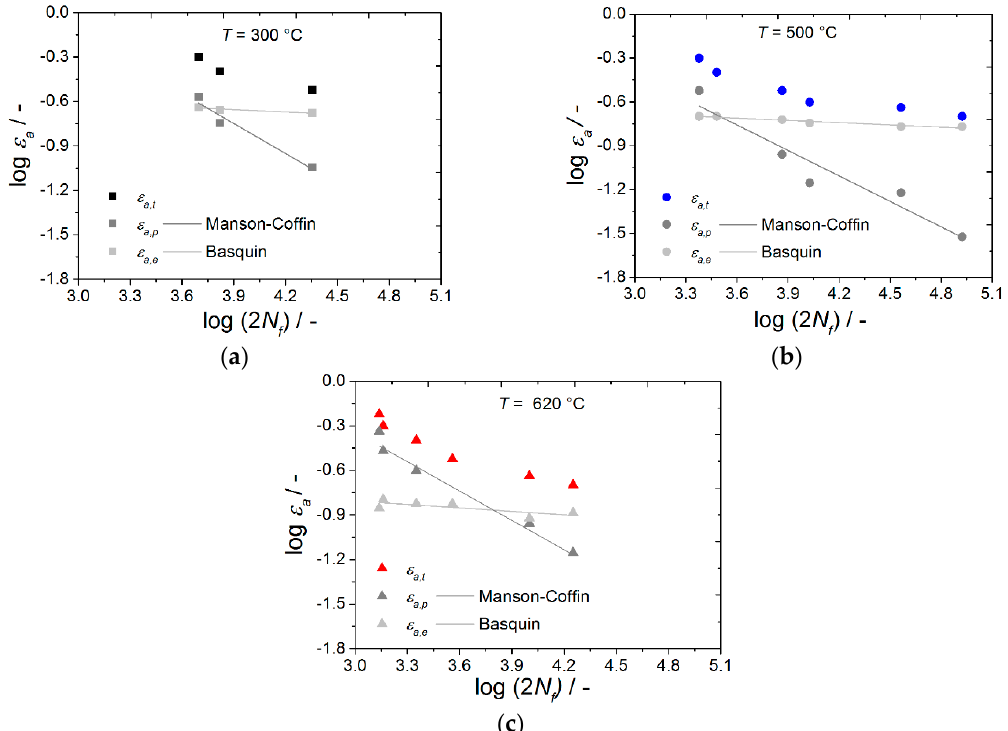
Figure 9. Manson-Coffin Basquin plots for the LCF-tests conducted at ( a ) 300 ◦ C, ( b ) 500 ◦ C, and ( c ) 620 ◦ C.